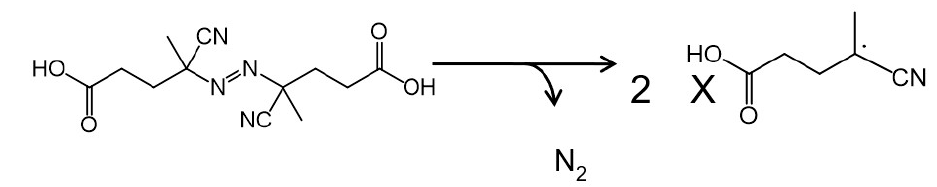
Figure 5. 4 , 4’-Azobis(4-cyanovaleric acid) used as a water-soluble radical generator.